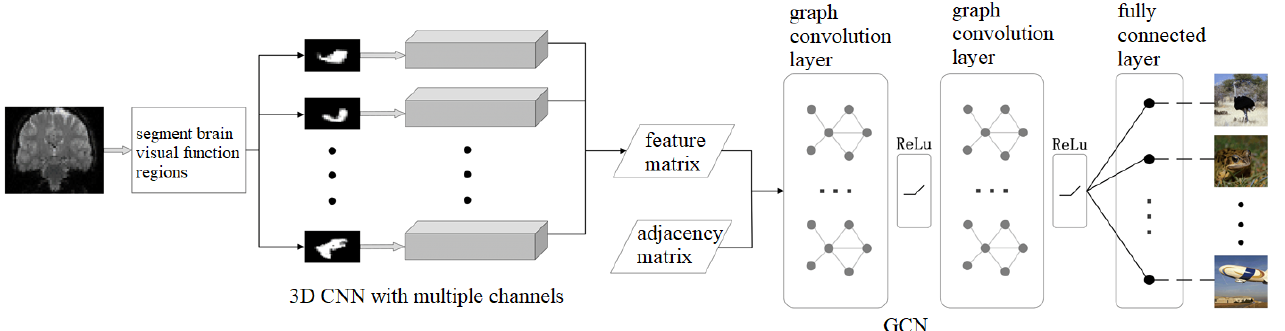
Figure 1. Overall architecture of the proposed algorithm.